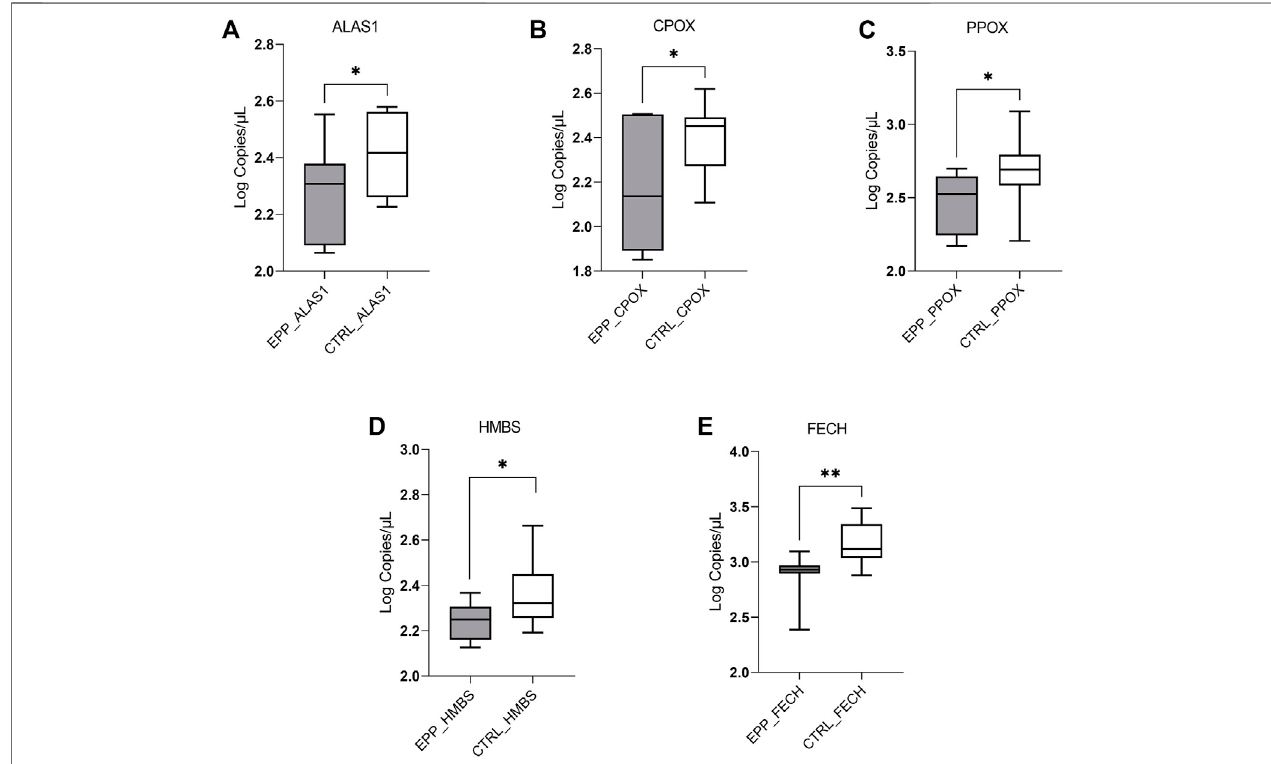
FIGURE 1 | Lower EPP gene expression reported in Log of copies/µl for (A) ALAS1; (B) CPOX; (C) PPOX (D) HMBS (E) FECH genes, between EPP patients and Controls ( p * < 0.05 ** p ≤ 0.01).